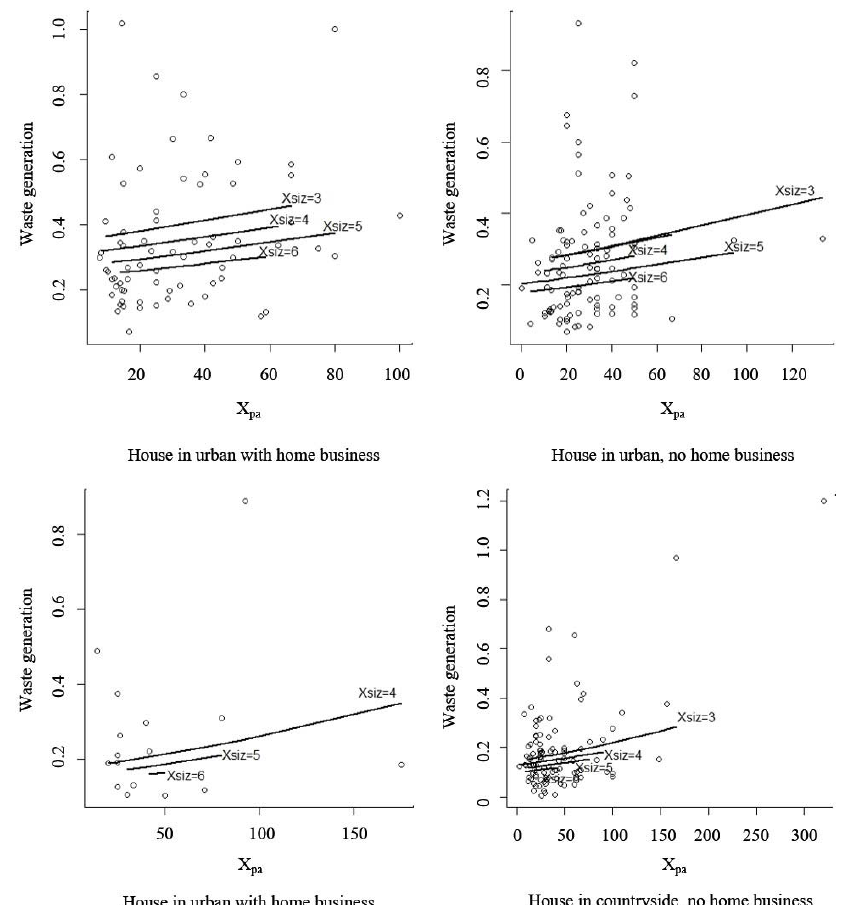
Fig. 4: Fitted line plot of a model with four regressors: X plc , X siz , X pa , and X bus